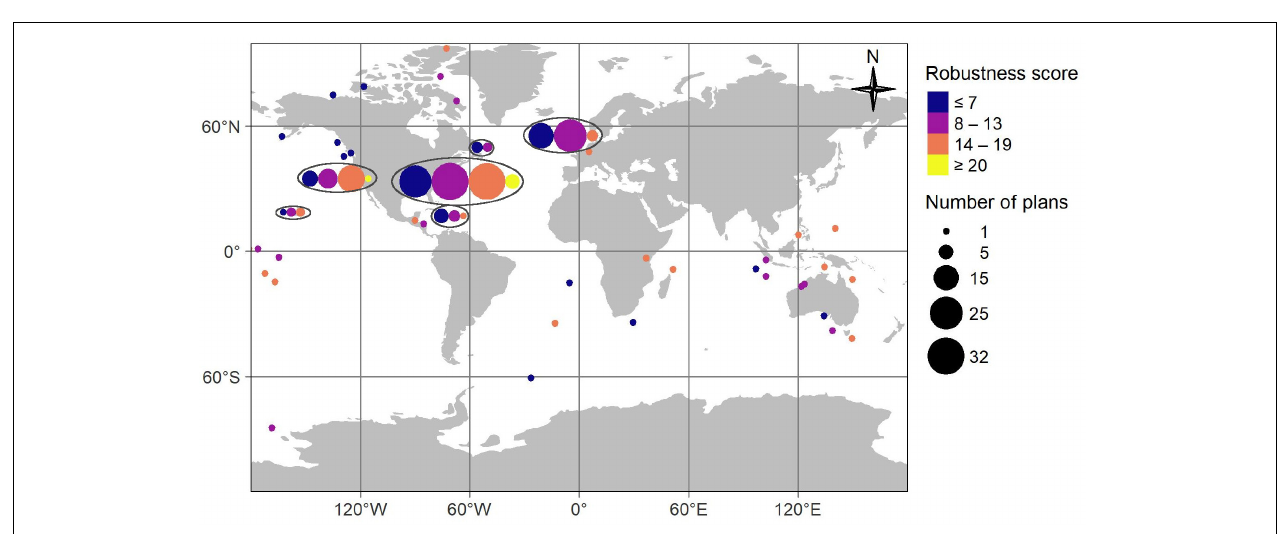
FIGURE 5 | The proportion of the 223 climate-considering MPA management plans that we manually reviewed that included a commitment to monitor climate change (question 4), specified indicators (question 6), indicator(s) specifically linked to climate change (question 8), targets (question 10), or thresholds (question 11).